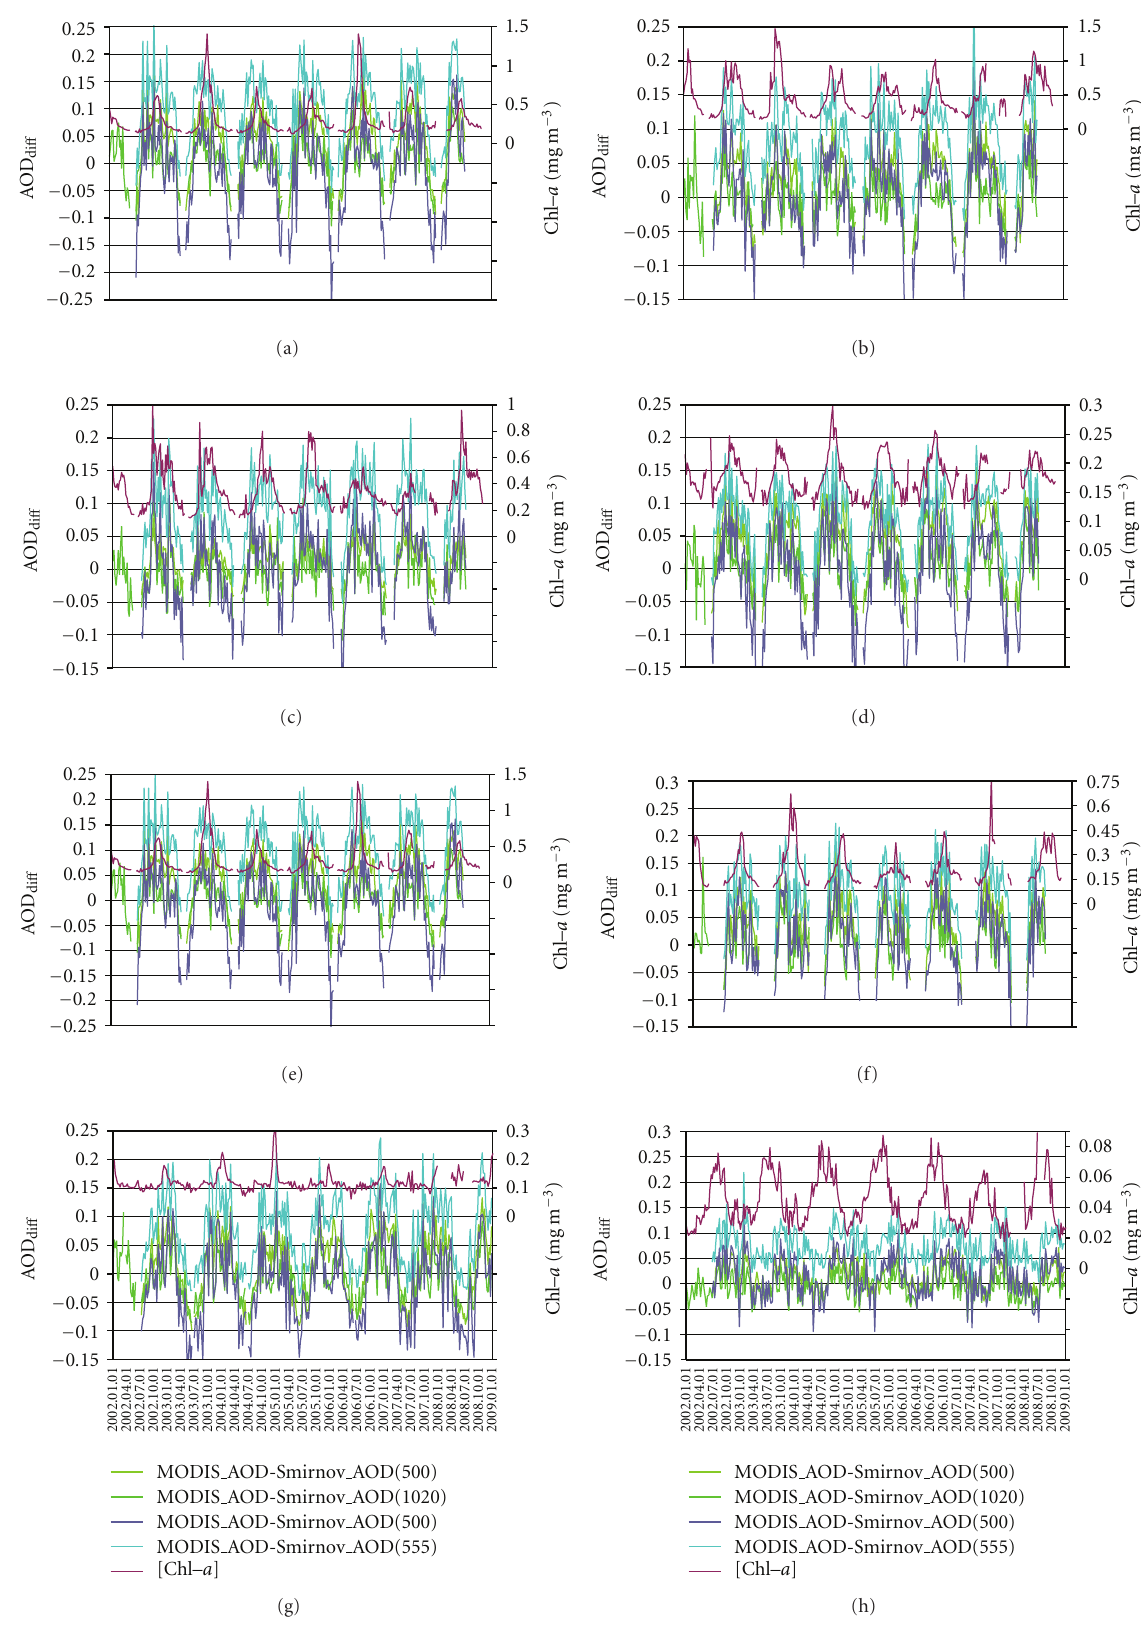
Figure 5: (a)–(h) Time series of the area-averaged AOD di ff (right axis) and [Chl- a ] (left axis) for the boxes 1–8 shown on Figure 4. The daily di ff erences in AOD values were averaged over 8